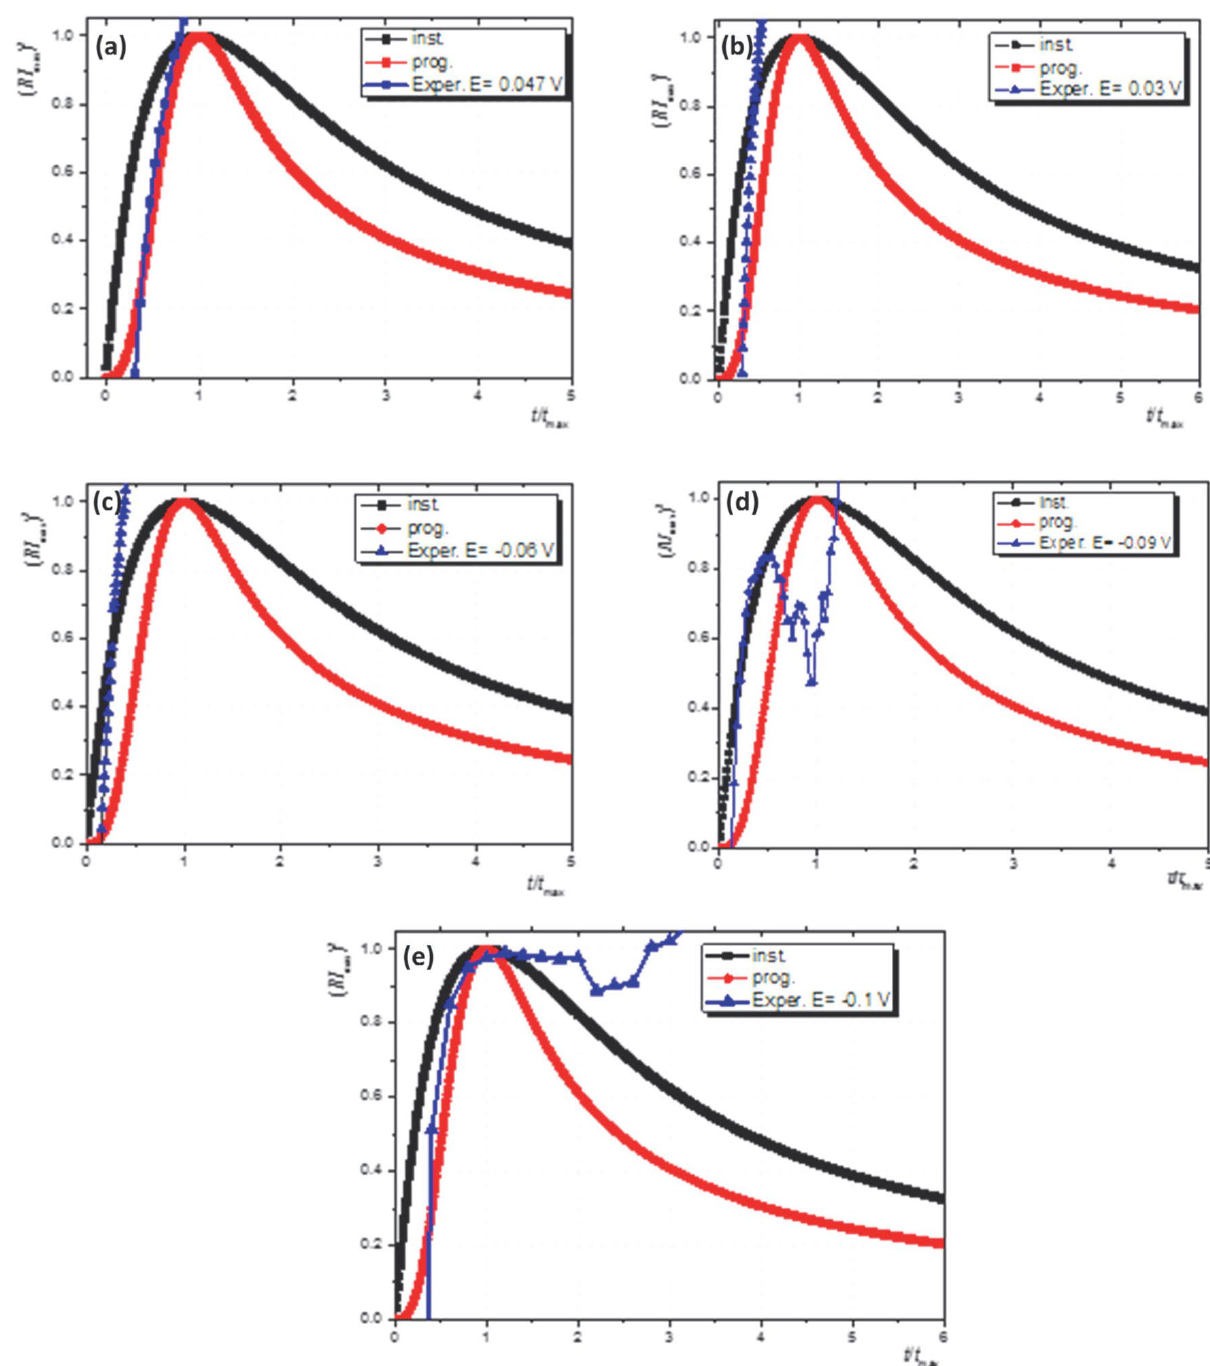
Fig . 8 . Comparison of theoretical non-dimensional plots of (I/I max ) 2 vs (t/t max ), for instantaneous and progressive nucleation with the experimental data derived from Fig.